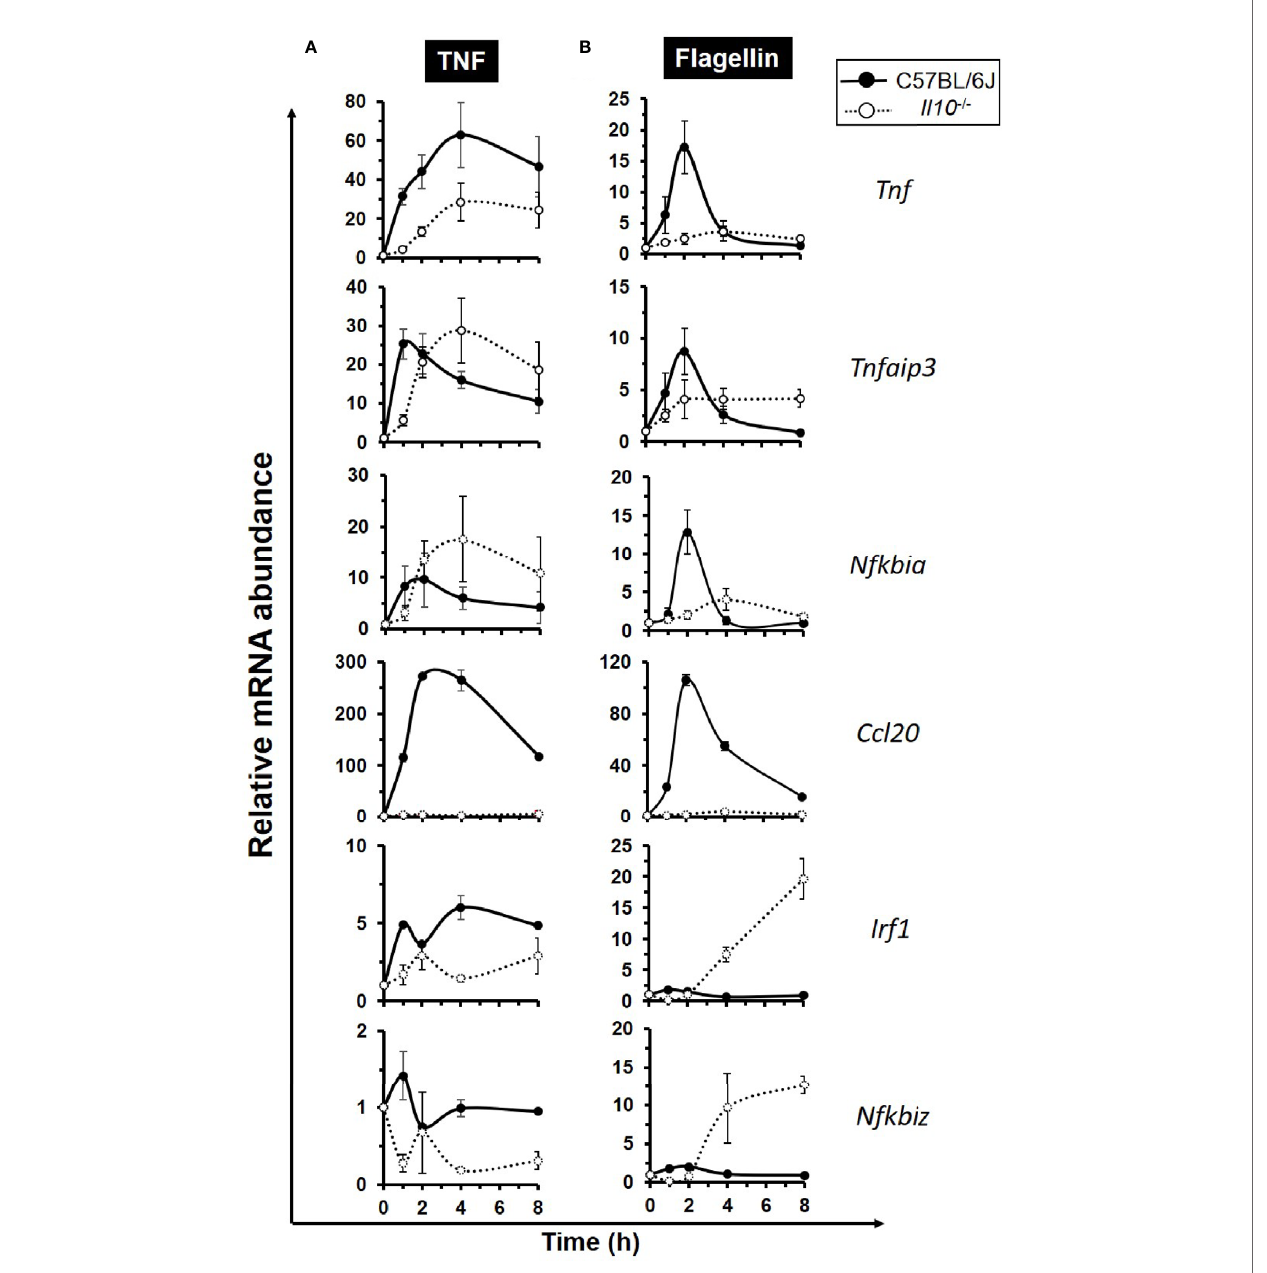
FIGURE 4 | Defective expression of the early response NF k B target genes in interleukin 10 de fi cient enteroids. Enteroid cultures from C57BL/6J and Il10 − / − mice were left unstimulated or stimulated with either (A) 40 ng/ml TNF, or (B) 100 ng/ml fl agellin, for up to 8 h. qPCR analysis of early response NF k B target genes Tnf , Tnfaip3 , Nfkbia , Ccl20 , Irf1 , and Nfkbiz was performed. Data is presented as mean ± SEM; N = 3 – 4